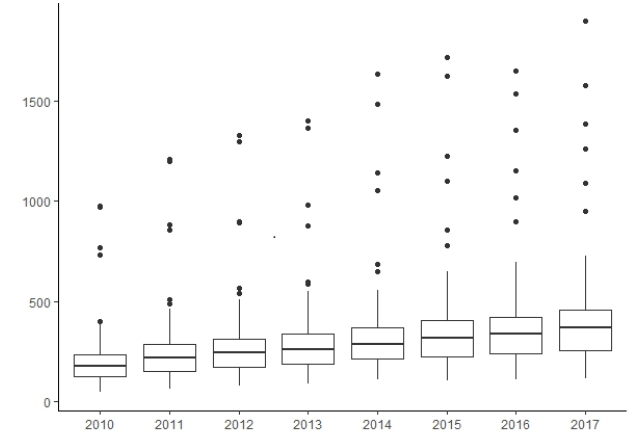
Figure 7. Dispersion of GDP per capita in the regions of Russia for